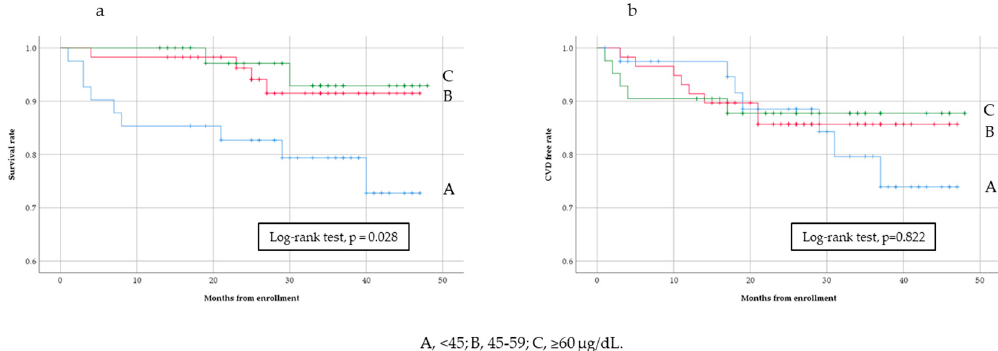
Figure 2. Histogram of serum zinc levels at baseline . 3.2. Correlation Analysis As shown in Table 2, serum zinc levels positively correlated with serum albumin levels, GNRI, and PhA and negatively correlated with eGFR, serum C-reactive protein, OH, OH/ECW, ECW, and E/I. On the other hand, significant differences were not observed between serum zinc levels and copper or iron levels. Following the stratification of groups by gender and the presence/absence of diabetes, serum albumin levels, GNRI, and PhA were positively correlated, while OH, OH/ECW, and ECW/ICW were negatively correlated with serum zinc levels in all groups (Figure S1 of Supplementary Materials). 3.3. Analysis of All-Cause Mortality and Cardiovascular Events During the follow-up period, there were 15 cases of all-cause mortality and 20 of cardiovascular events. Figure 3a shows that the all-cause mortality rate was significantly higher in the lowest group (<45 µg/dL) than in the other groups (Kaplan–Meier analysis, Log-rank test, p = 0.028). Similar results